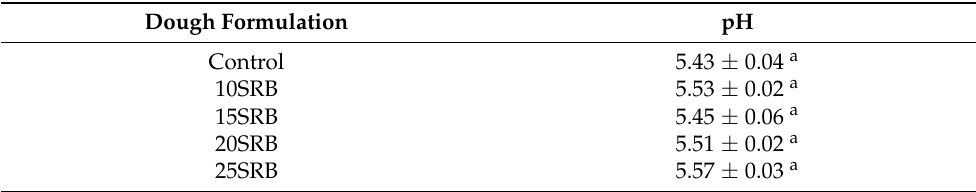
Table 4. pH values of control and experimental doughs formulated with different levels of SRB